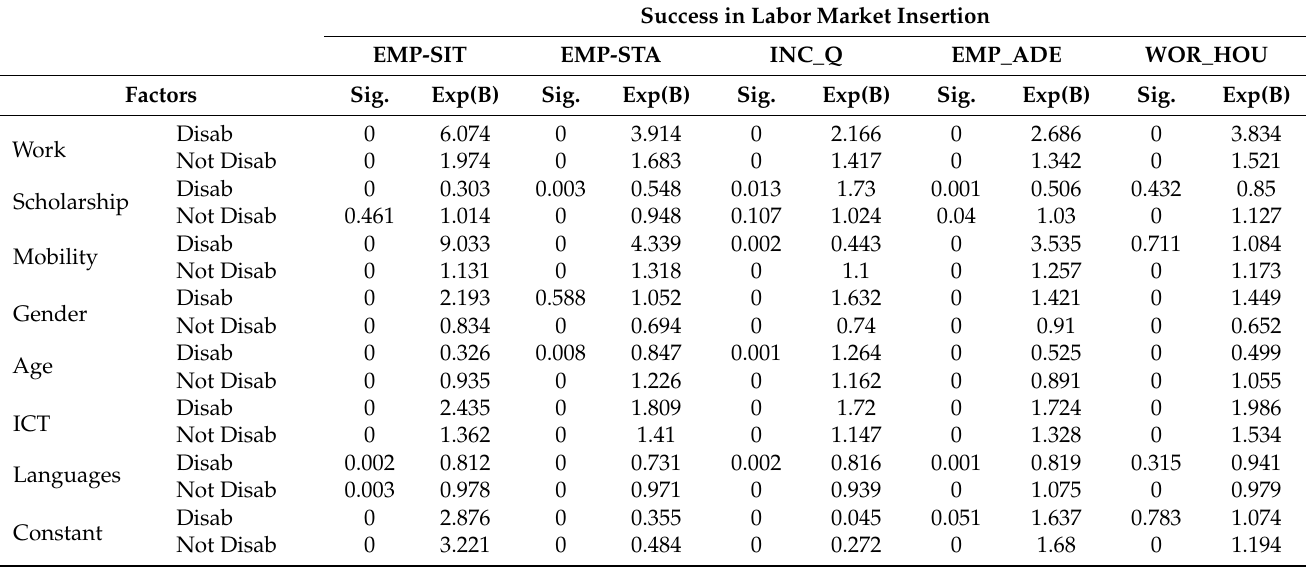
Table 3. Effect of external factors on the success of labor market insertion of graduates in Spain.